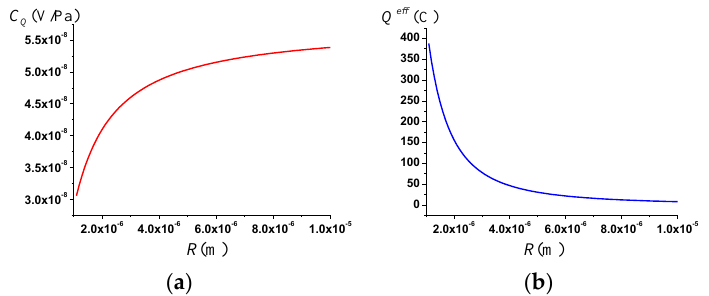
Figure 1. Effect of water saturation (steady case): ( a ) streaming potential coupling coefficient; ( b ) effective net residual charge density.